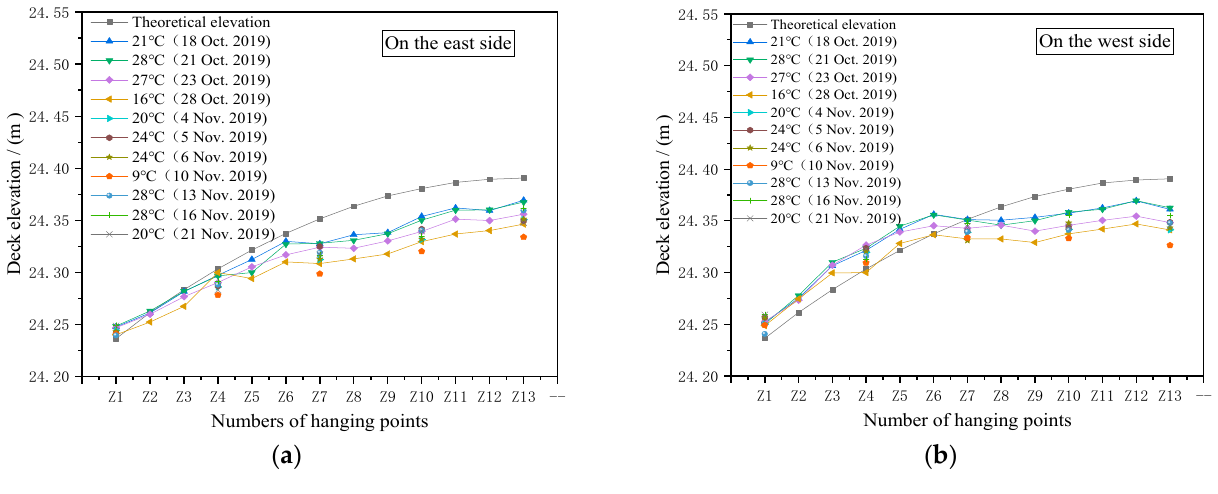
Figure 13. Deck elevation at the hanging point under different temperatures. ( a ) Eastside hanging point area. ( b ) Westside hanging point area.